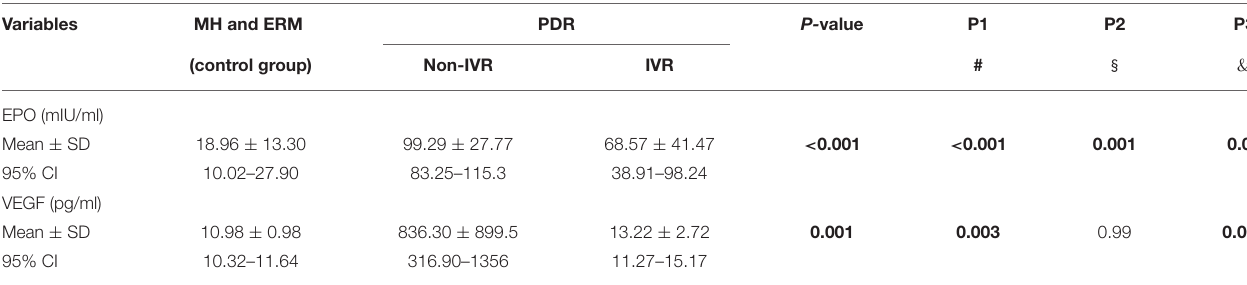
TABLE 2 | Vitreous levels of erythropoietin and vascular endothelial growth factor (VEGF). Variables